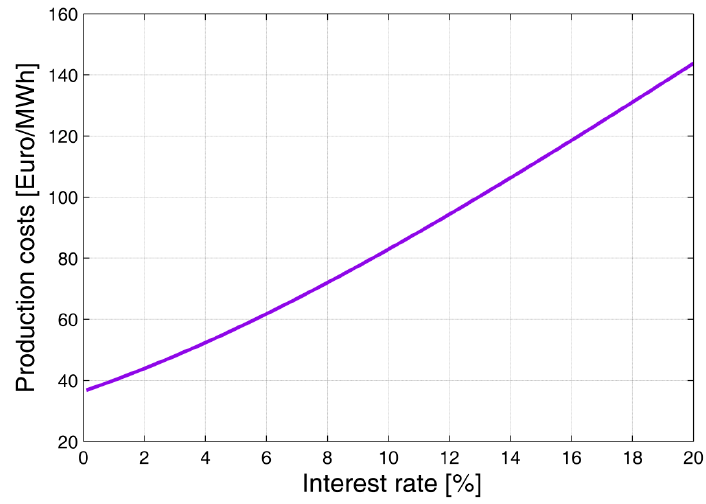
Figure 12. The dependence of the production costs of the FPPP on the interest rate.